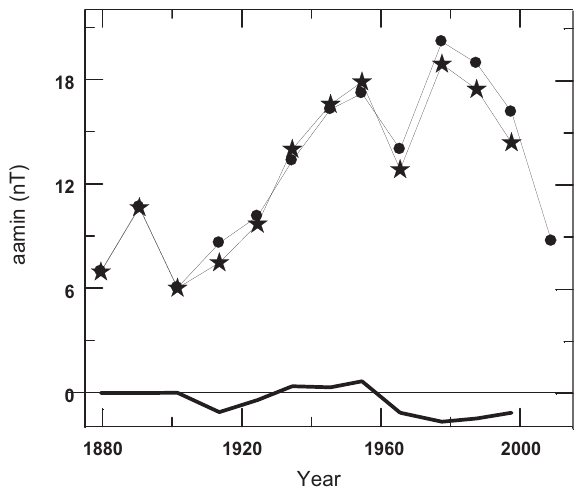
Fig. 2. A comparison of the time series of the Standard aa data ((ftp://.ngfc.noaa.gov/STP/SOLARDATA/REALTED_INDICES/ AA_INDEX/AA_YEAR) (points) and the Lockwood data (stars; priv. comm., 2009). The line at the bottom of the figure is the difference between the two